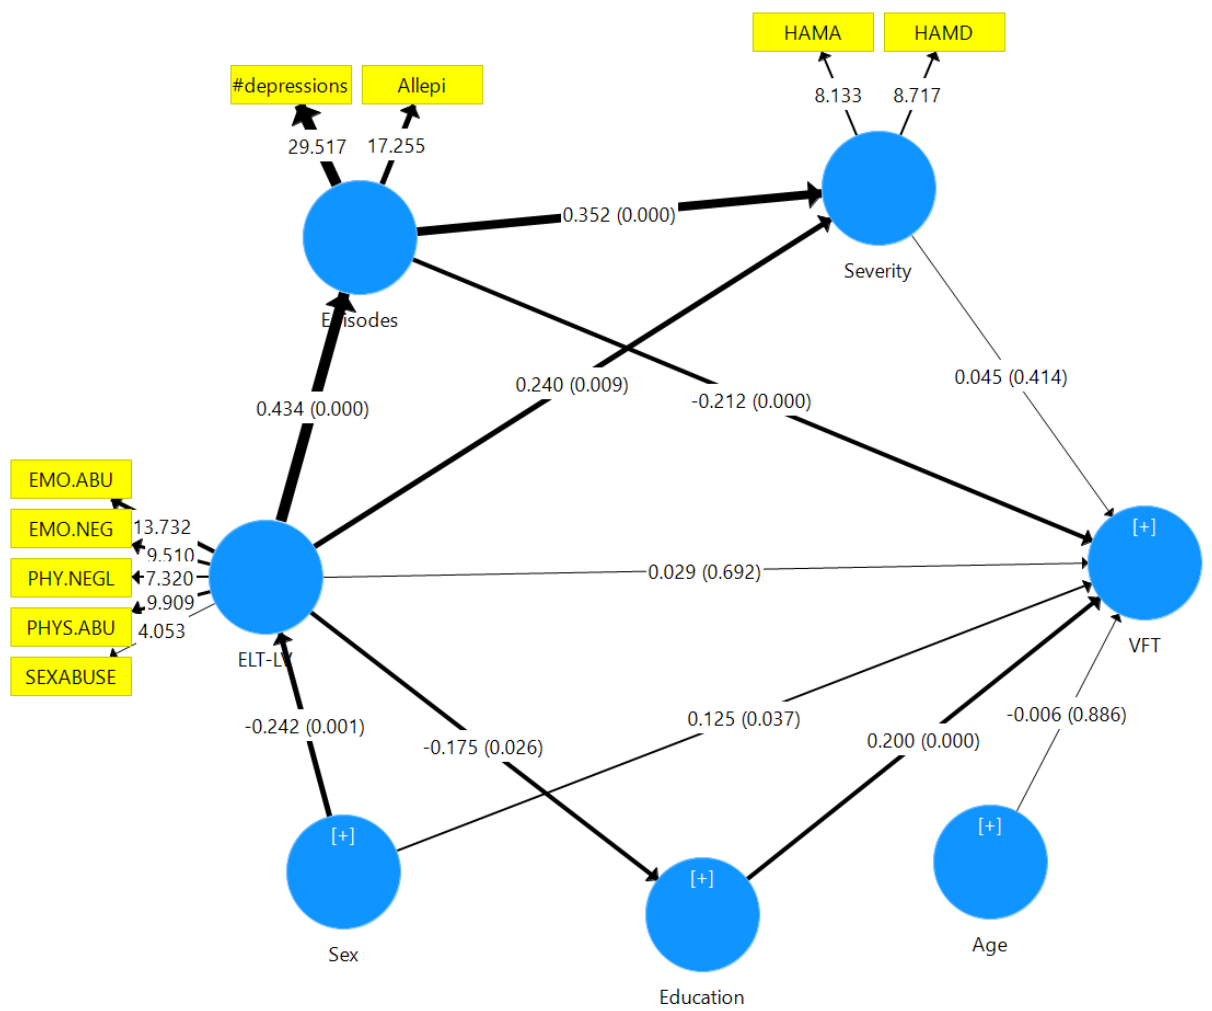
Figure 3: Results of partial least squares (PLS) path analysis with verbal fluency test (VFT) as outcome variable and a latent vector (LV) extracted from Hamilton Depression (HAM-D) and Anxiety (HAM-A) Rating Scale scores; episodes LV, extracted from number of depressions and total number of episodes; age; education; sex and a LV extracted from 5 early lifetime trauma (ELT LV) as explanatory